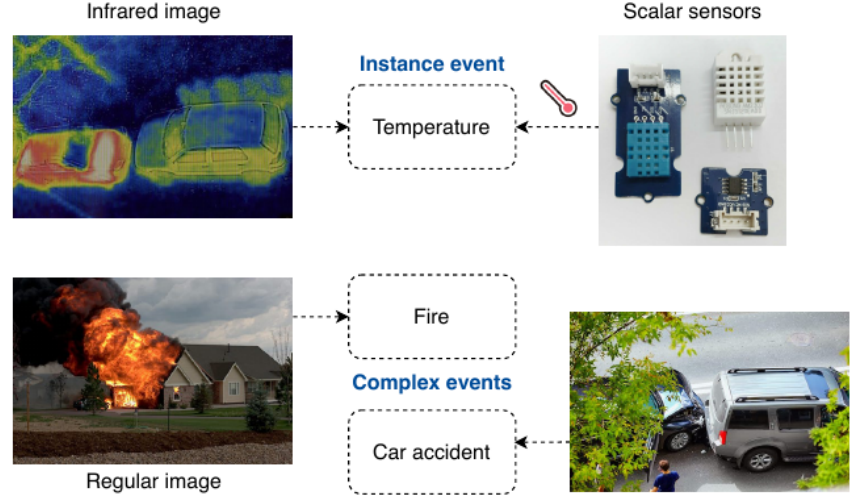
Figure 1. The use of visual data when detecting different types of critical